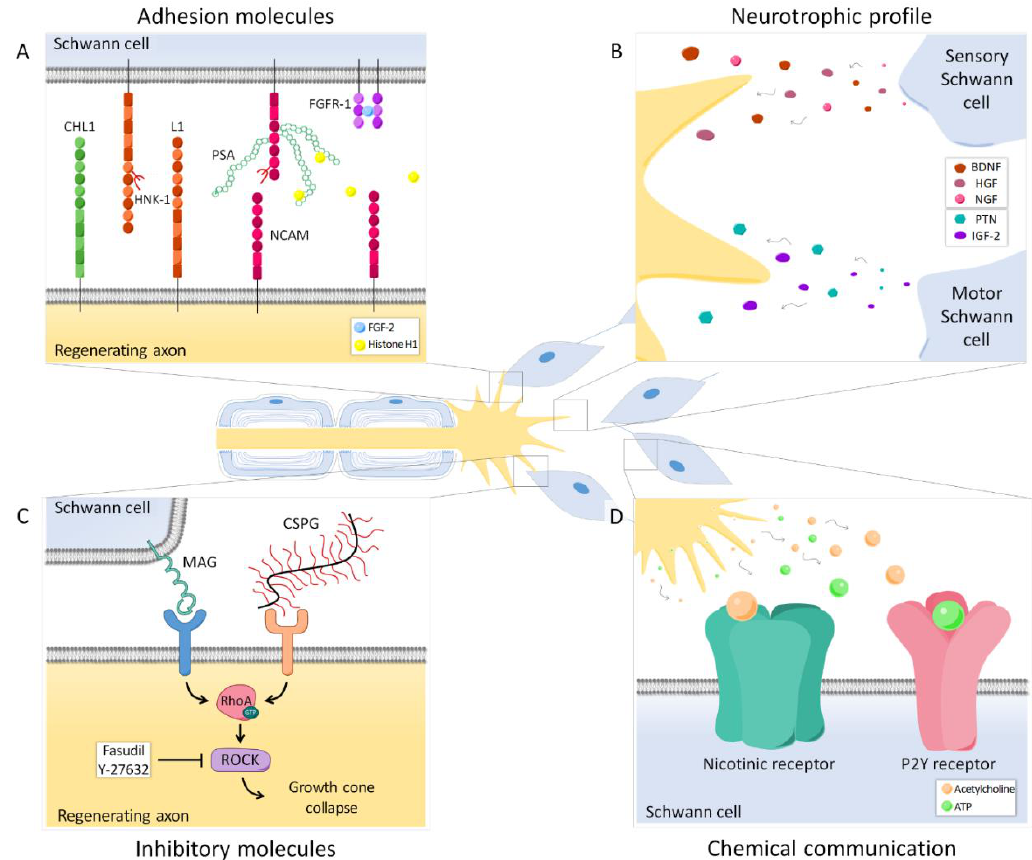
Figure 2. Axon-SC intercommunication during regeneration occurs in different ways and can modulate preferential reinnervation. ( A ) Several adhesion molecules play an important role in guiding axons to their target organs. Polysialic acid (PSA), mainly carried by NCAM, is differentially expressed in the cutaneous and muscle branch of the femoral nerve and its presence can be crucial for specific regeneration. Histone H1 is a PSA ligand that can enhance PMR, whereas FGF-2 promotes regeneration and could also favor specificity, presumably increasing FGFR1 and PSA-NCAM interaction. Other adhesion molecules such as CHL1, L1 and the HNK-1 carbohydrate are also relevant in this process. ( B ) Neurotrophic factors secreted by SCs after nerve injury are important for neuronal survival. Denervated motor and sensory SCs have a specific growth factor expression profile; therefore, regenerating axons receive different signals from the cutaneous and muscle branch of the nerve that can influence axonal pathway choice. ( C ) Some molecules from SCs (MAG) or the extracellular matrix (CSPG) have an inhibitory effect on axonal regeneration. Both MAG and CSPG can activate the small GTPase RhoA and its downstream effector ROCK in axons, resulting in growth cone collapse. Blocking this cascade has a differential effect in motor and sensory axons, thus revealing these inhibitory molecules as candidates for the regulation of PMR. ( D ) SCs can respond to neurotransmitters released by regenerating axons. Particularly, SCs have nicotinic acetylcholine receptors and purinergic P2Y receptors, which allow them to respond to acetylcholine and ATP respectively. This chemical interaction also modulates axon regeneration and